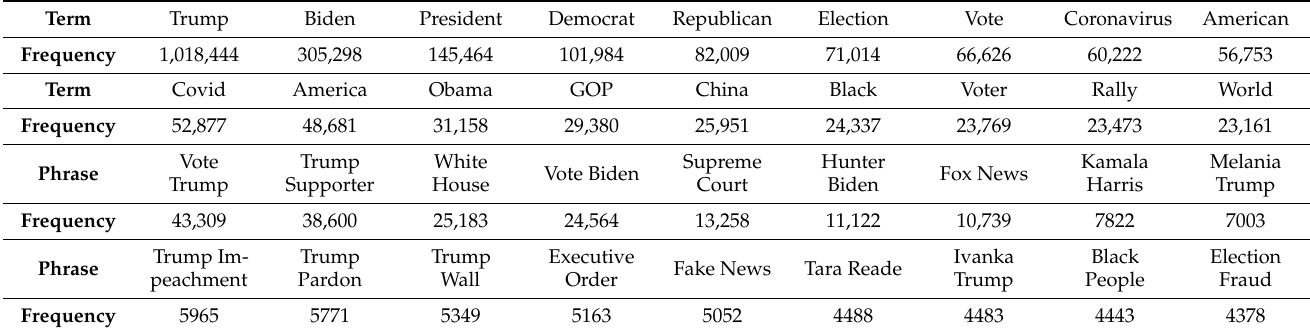
Table 1. The most frequent terms and phrases among